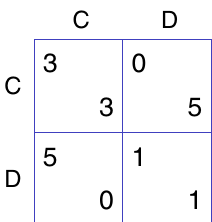
Figure 1 | Payoff matrix. If both players cooperate, each player receives 3, if one cooperates and one defects, cooperator receives 0 and defector receives 5, if both defect, each player receives